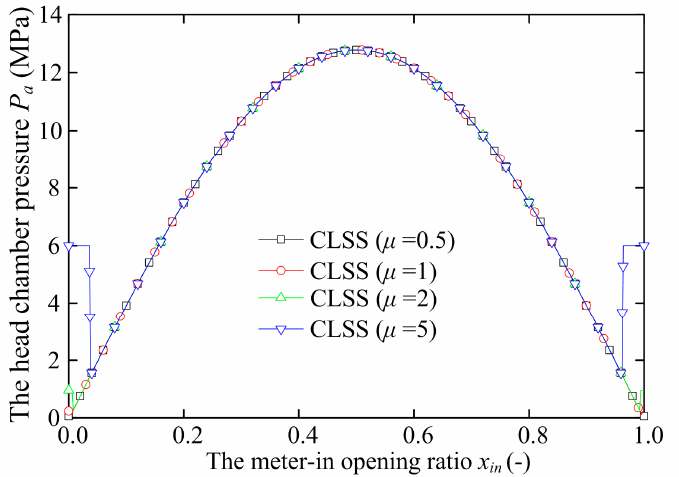
Figure 18. The head chamber pressure P a of CLSS with retraction working mode.